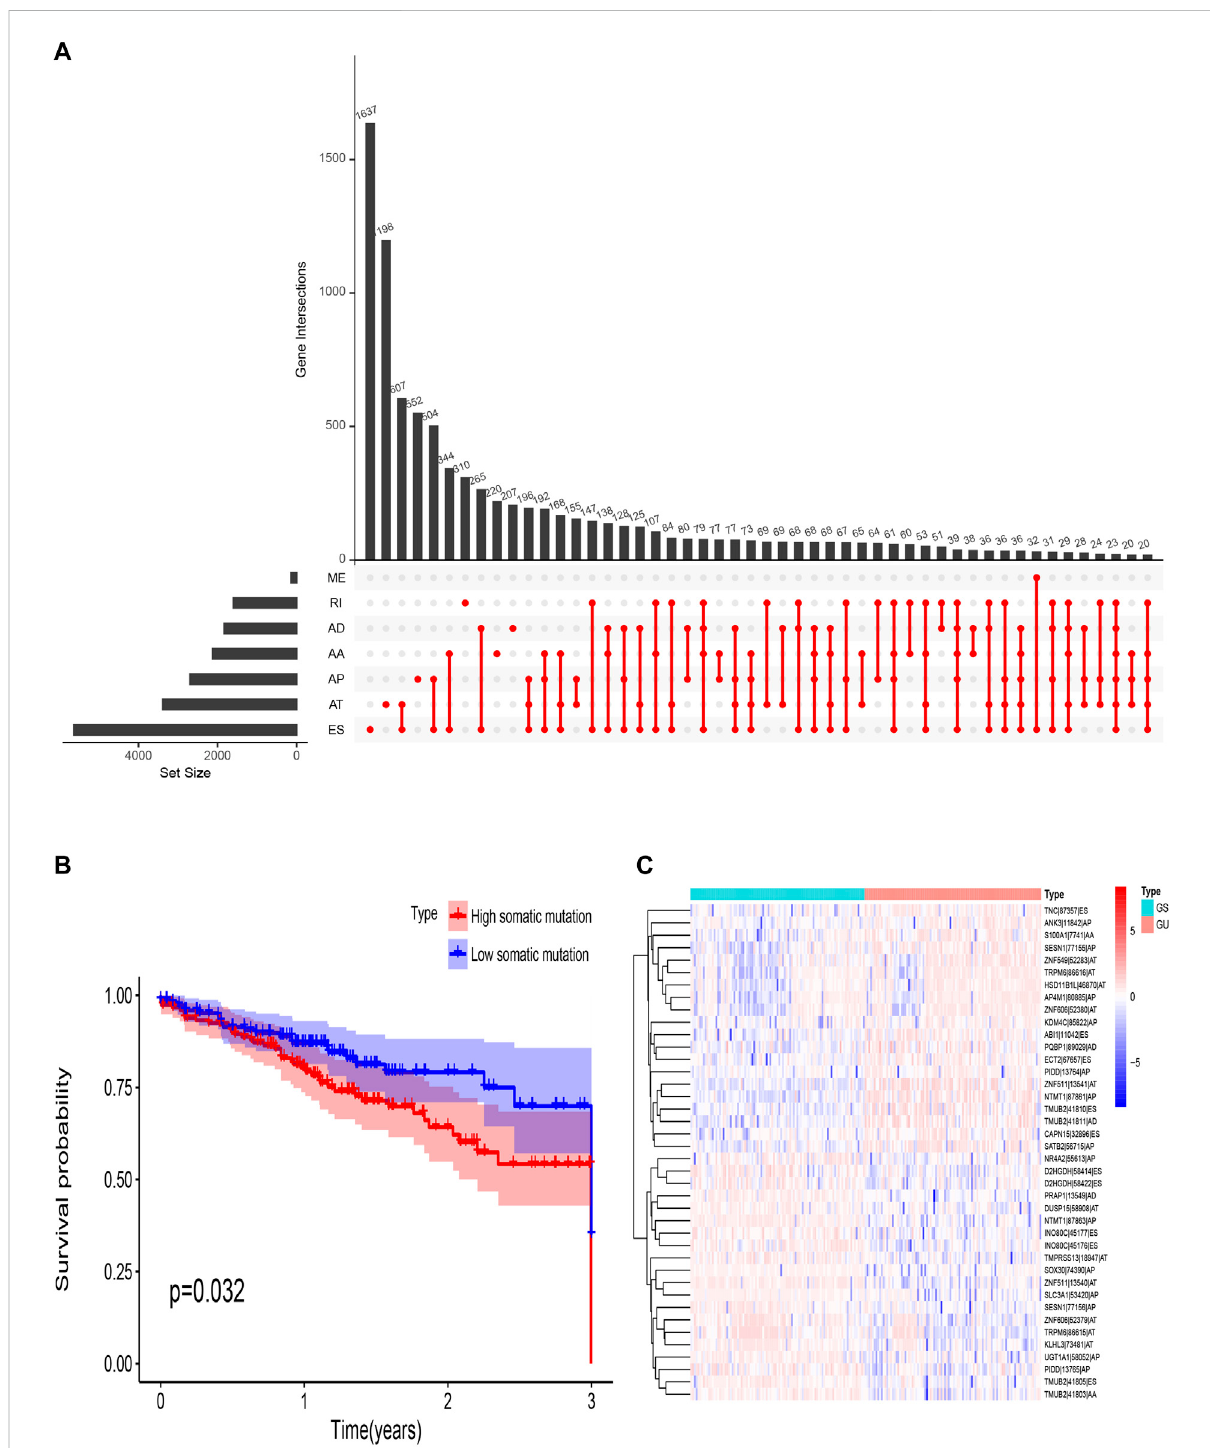
FIGURE 2 Overview of AS events in TCGA CRC cohort. (A) Upset plot for all AS events. AS, alternative splicing; RI, retained intron; ME, mutually exclusive exons; ES, exon skipping; AT, alternative terminator; AP, alternative promoter; AD, alternative donor site; AA, alternative acceptor site. (B) Survival probability of different somatic mutation group. (C) Heat map of genomic instability-related AS events. TCGA, The Cancer Genome Atlas; CRC, Colorectal